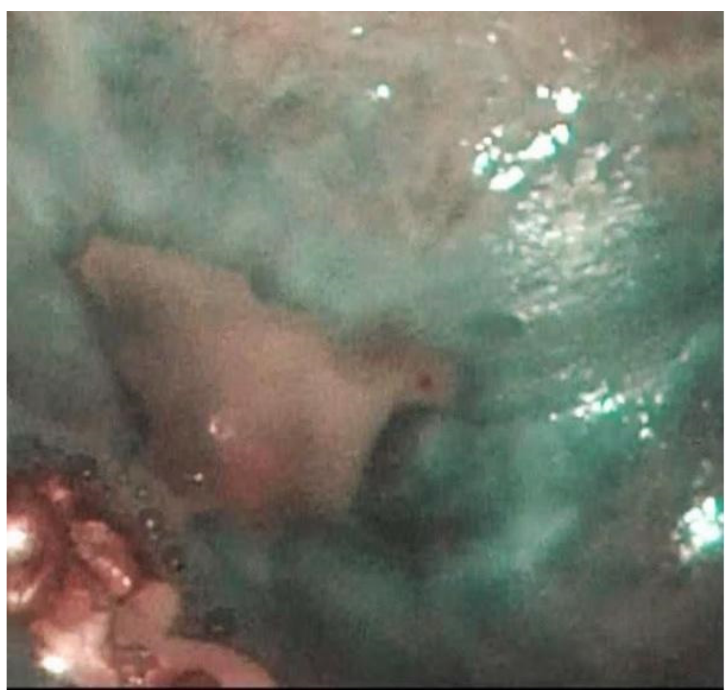
Figure 5. Erythroplasic lesion with peripherical vascular dark spots enhanced with narrow band imaging.